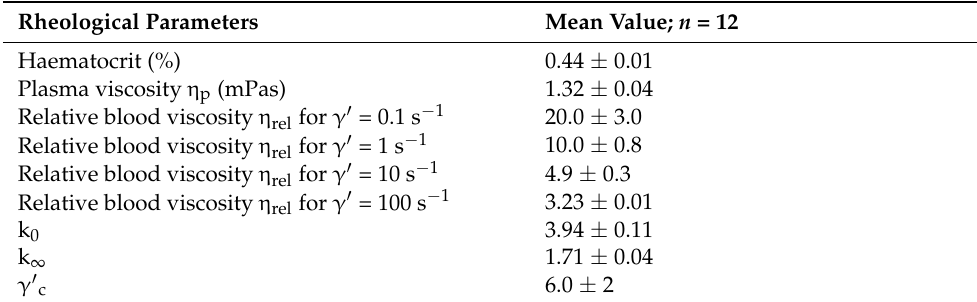
Table 1. Mean values of hemorheological parameters for the study group of patients experiencing tinnitus. The variables k ∞ and k 0 in the Quemada formula (1) are interpreted as measures of ery- throcyte stiffness and the degree of aggregation, whereas k Q corresponds to the so-called erythrocyte intrinsic viscosity accounting for erythrocyte shape variation.